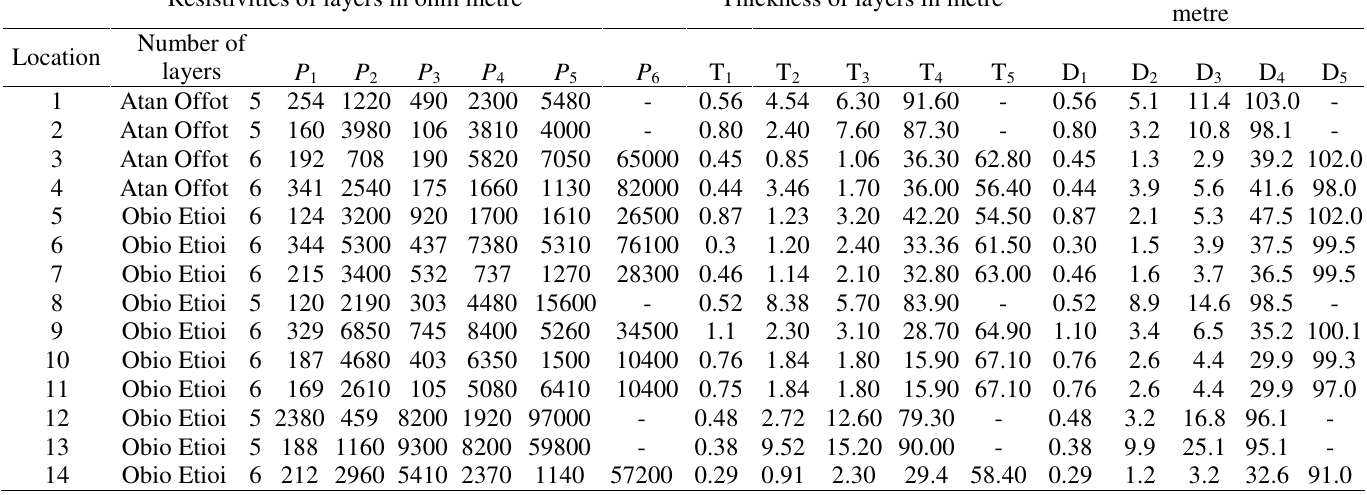
Table 1. Summary of vertical electrical sounding results from computer modeling.